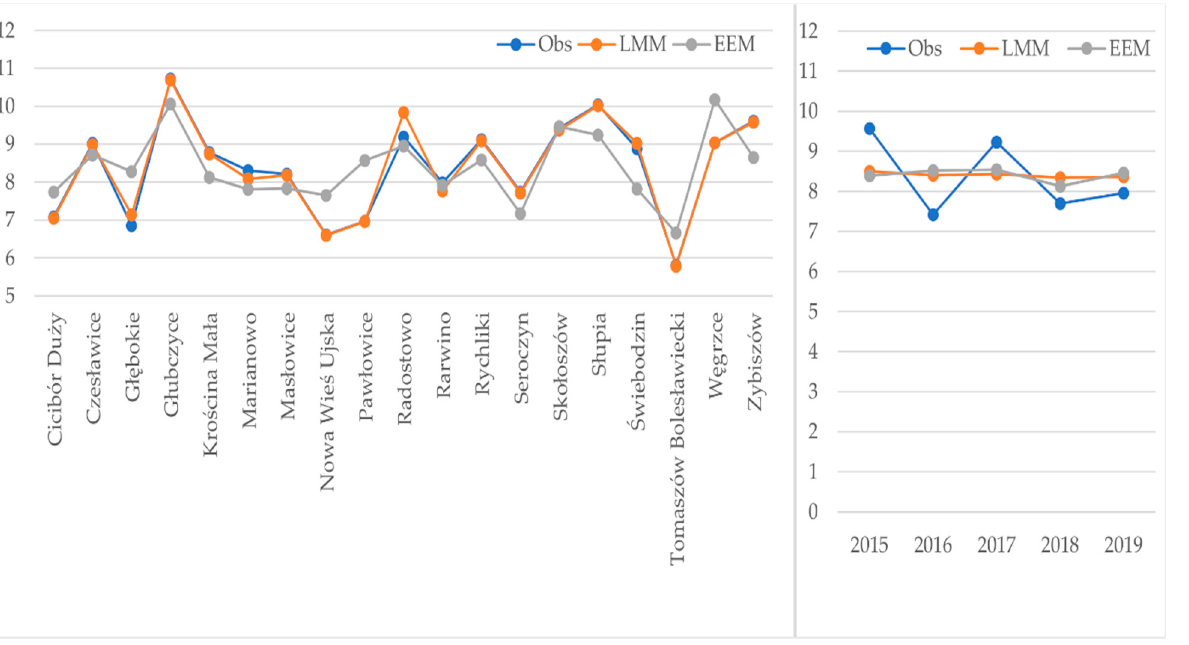
Figure 1. Average yield (t/ha) in trial locations ( left ) and in years ( right ): observed, adjusted using linear mixed model (LMM) and estimated by the explanatory environmental model (EEM).